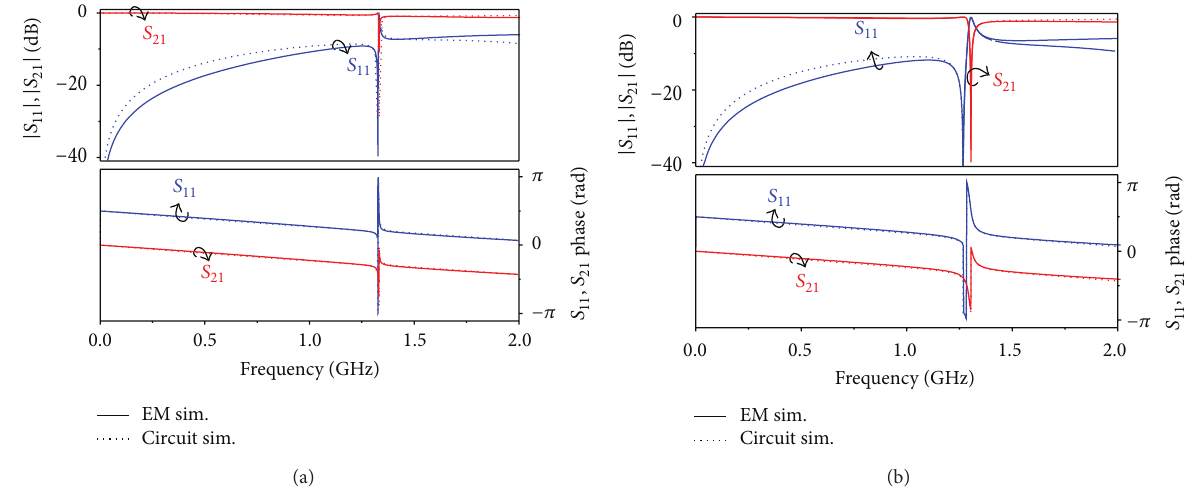
Figure 10: Frequency response for the structure of Figure 8 that results by laterally shifting the MLC 0.5 mm (a) and 2mm (b) and for its circuit model of Figure 9. The circuit parameters are 𝐿 𝑚 = 3.71 nH and 𝐶 𝑔 = 9.5 pF; for 0.5 mm, 𝐿 = 9.48 nH, 𝐶 1 = 0.89 pF, 𝐶 2 = 0.36 pF, and 𝐶 𝑚 = 0.59 pF; for 2mm, 𝐿 = 8.94 nH, 𝐶 1 = 1.36 pF, 𝐶 2 = 0.083 pF, and 𝐶 𝑚 = 0.66 pF.